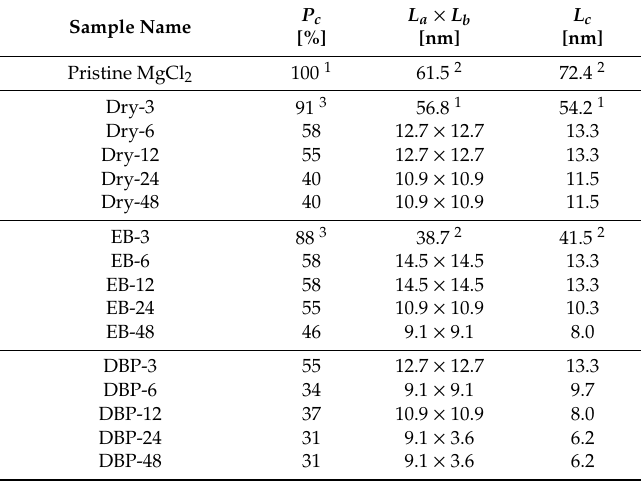
Table 1. PXRD fitting results for mechanically activated MgCl 2